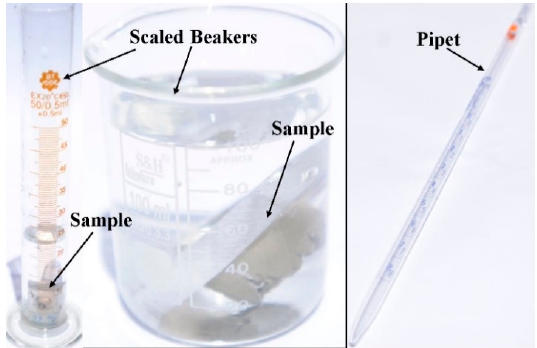
Figure 4. Beakers, pipet, and samples, whose volumes were measured.